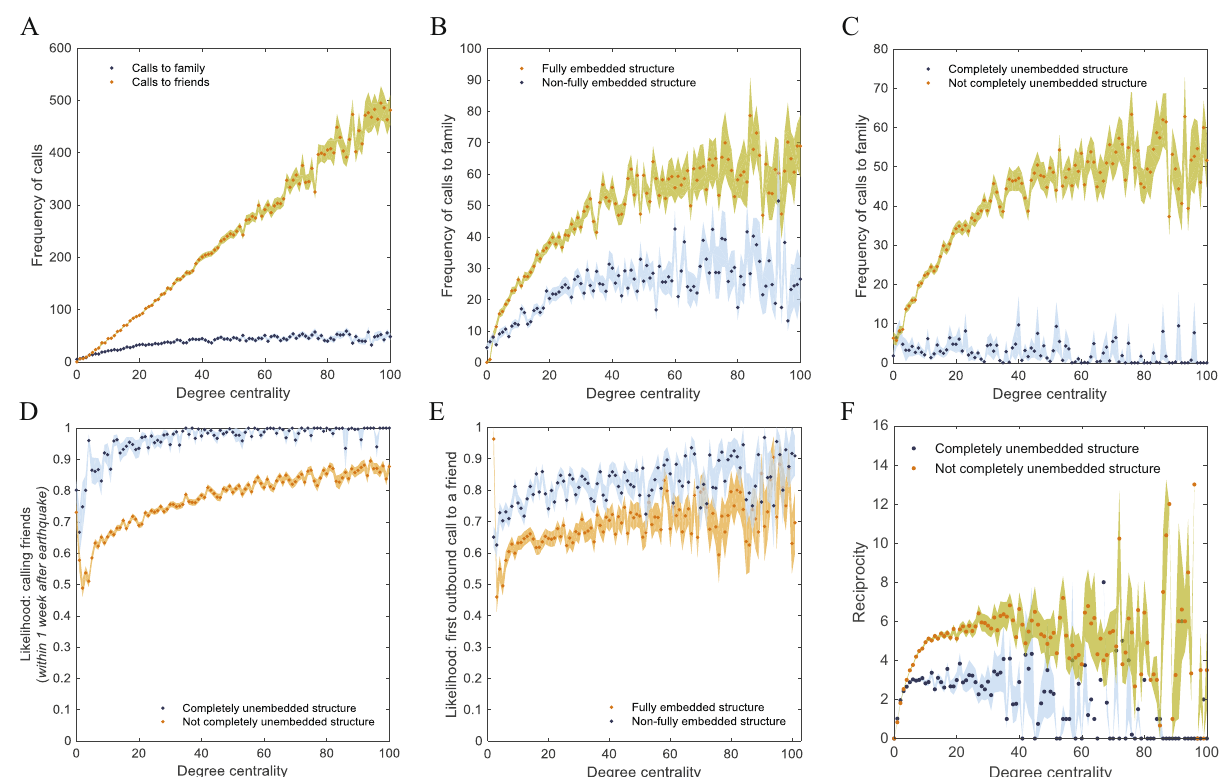
Fig. 2 Embeddedness structure and communications frequency at different levels of degree centrality. A Frequency of calls to friends (family) increased (was relatively fl at) with degree centrality. At each level of degree centrality, B egos in fully embedded families made more calls to family than those in non-fully embedded families ( M = 40.68 vs. 20.76, p < 0.001). C Egos in completely unembedded family structures made signi fi cantly fewer calls to family than those in non-completely unembedded family structures ( M = 3.10 vs. 35.13, p < 0.001). D Proportion of calls to friends the fi rst week after the earthquake is greater for egos in non-completely unembedded vs. completely unembedded family structures ( M = 0.944 vs. 0.732, p < 0.001). E Egos were more likely to fi rst call a friend when they are in non-fully embedded vs. fully embedded family structures (0.664 vs. 0.800, p < 0.001). F Egos are less reciprocal when they are in completely unembedded vs. non-completely unembedded family structures ( M = 1.945 vs. 5.113, p < 0.001). We observe consistent results for completely embedded vs. non-completely embedded, or completely unembedded vs. completely unembedded family structures for each dependent variable (see Supplementary Figs. 9 – 11 for analogous fi gures). N = 35,565 users from 11,855 three-person family plans; error bands denote 95% con fi dence